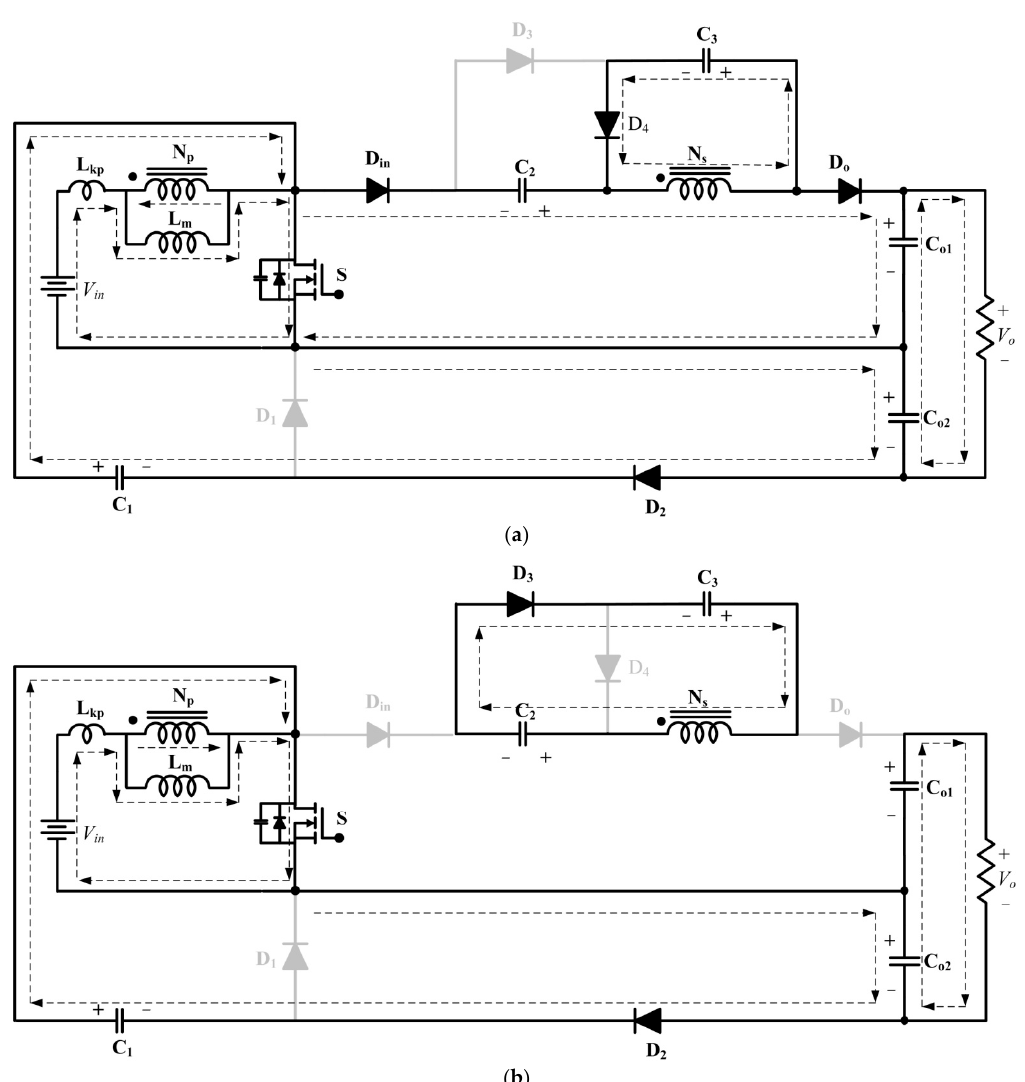
Figure 3. Operating modes at CCM during a switching period (Switch turn on). ( a ) Modes I; ( b ) Modes